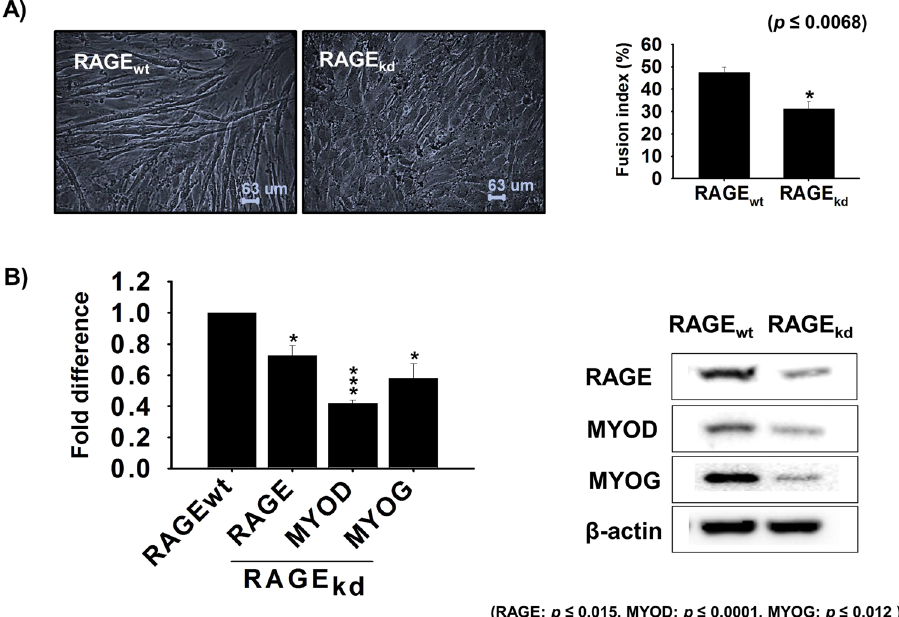
Figure 3. RAGE gene expression and the effects of its knock-down during differentiation. RAGE knock-down in C2C12 cells ( A ) Effect of RAGE knock-down on differentiation as determined by myotube formation and by using fusion indices. ( B ) RAGE, MYOD, and MYOG expressions in RAGE kd cells were determined by real time PCR and Western blot (n = 3).